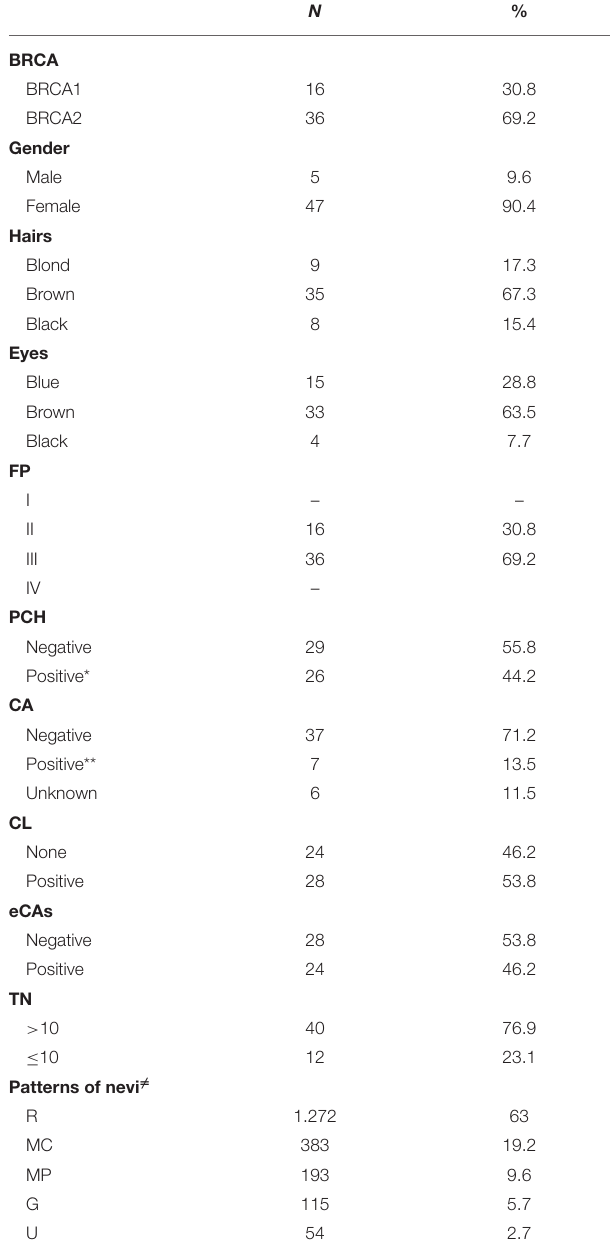
TABLE 1 | Clinicopathologic features of the